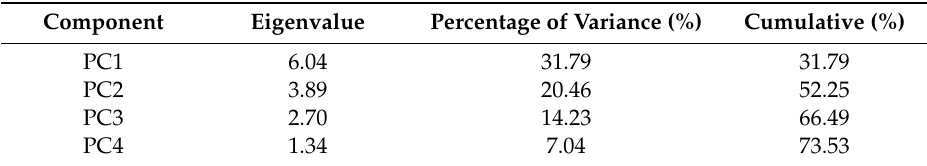
Table 6. Total variance explained by principal component analysis